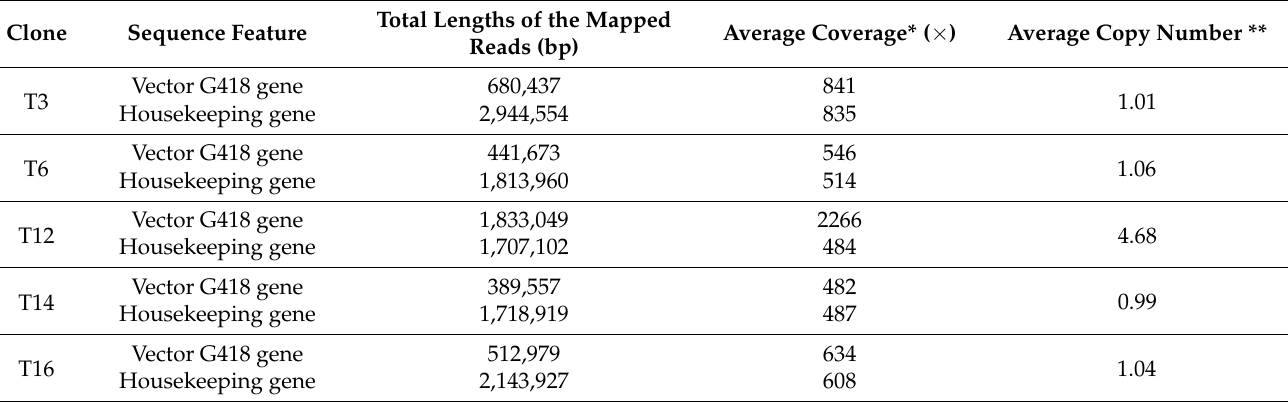
Table 2. Mapping summary of short reads back to vector sequence (pOLK4) and estimated insert copy number in each transformed (Tx) clonal line. The vector-selectable marker encodes resistance to the antibiotic G418 (809 bp). The housekeeping gene is the DNA directed DNA polymerase II gene (BE221DRAFT_187986) (3527 bp), present in a single copy in the reference